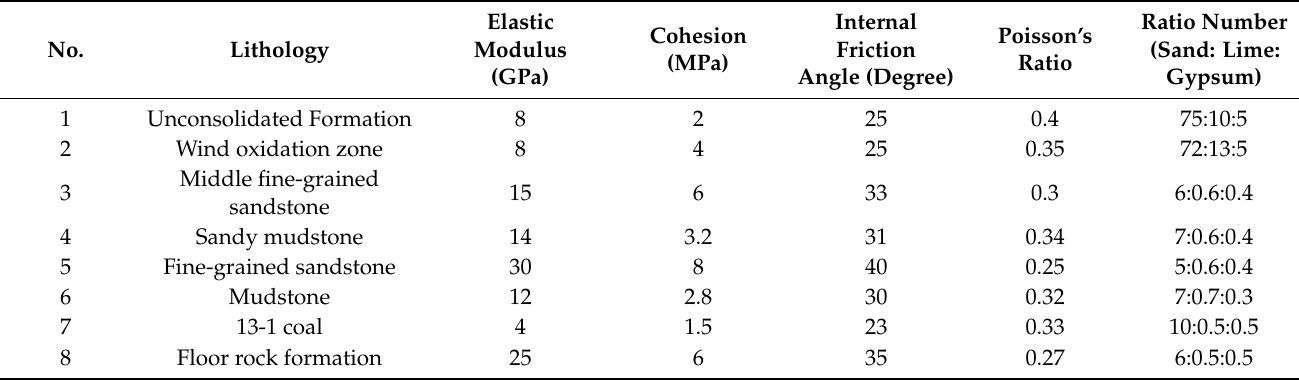
Table 2. Mechanical parameters of the investigated